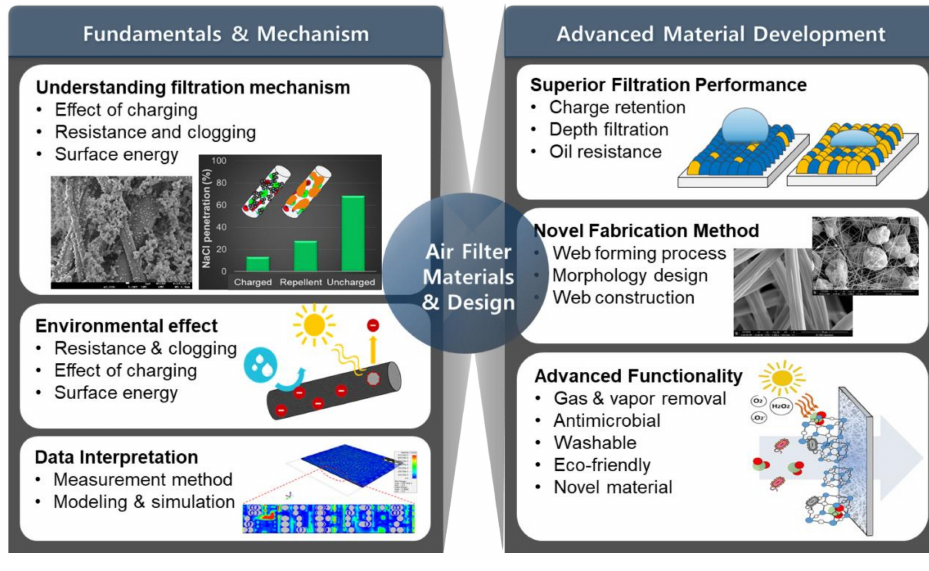
Figure 2. Research topics related to air